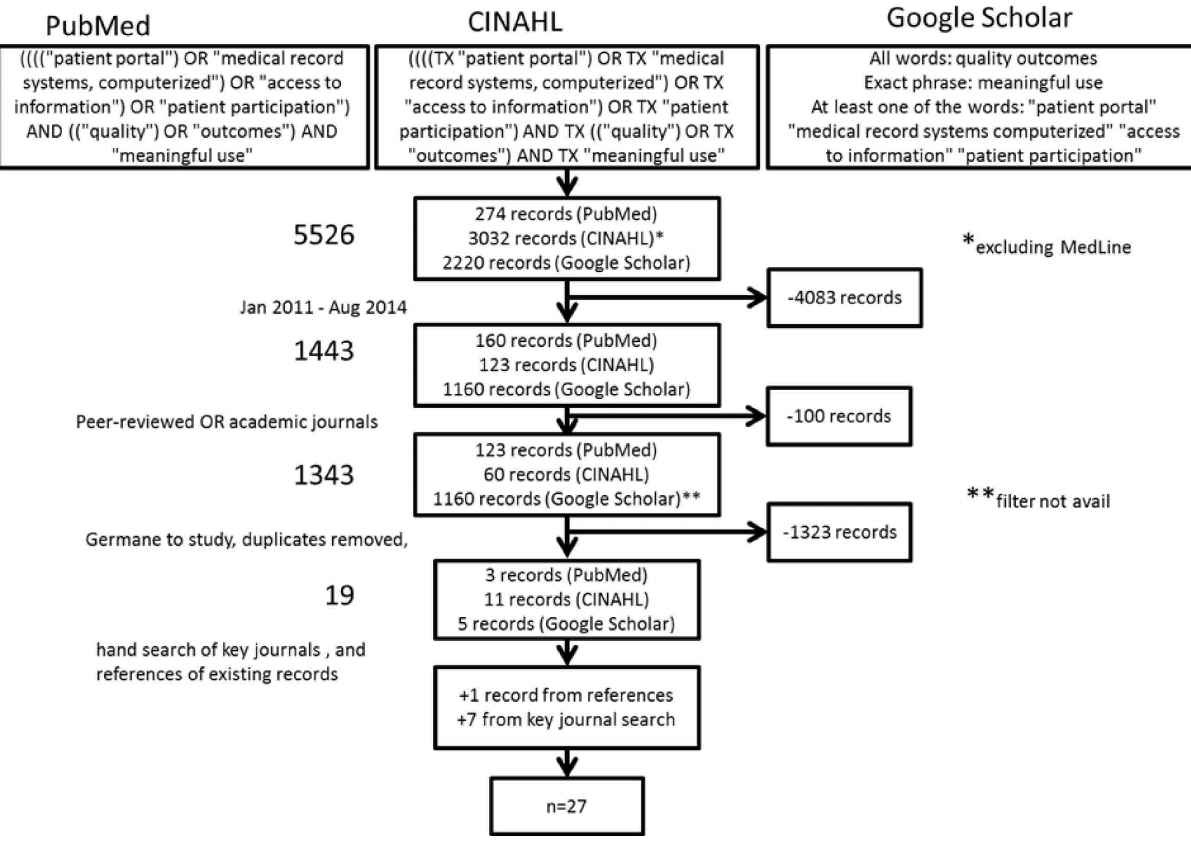
Figure 1. Search criteria and filters by search